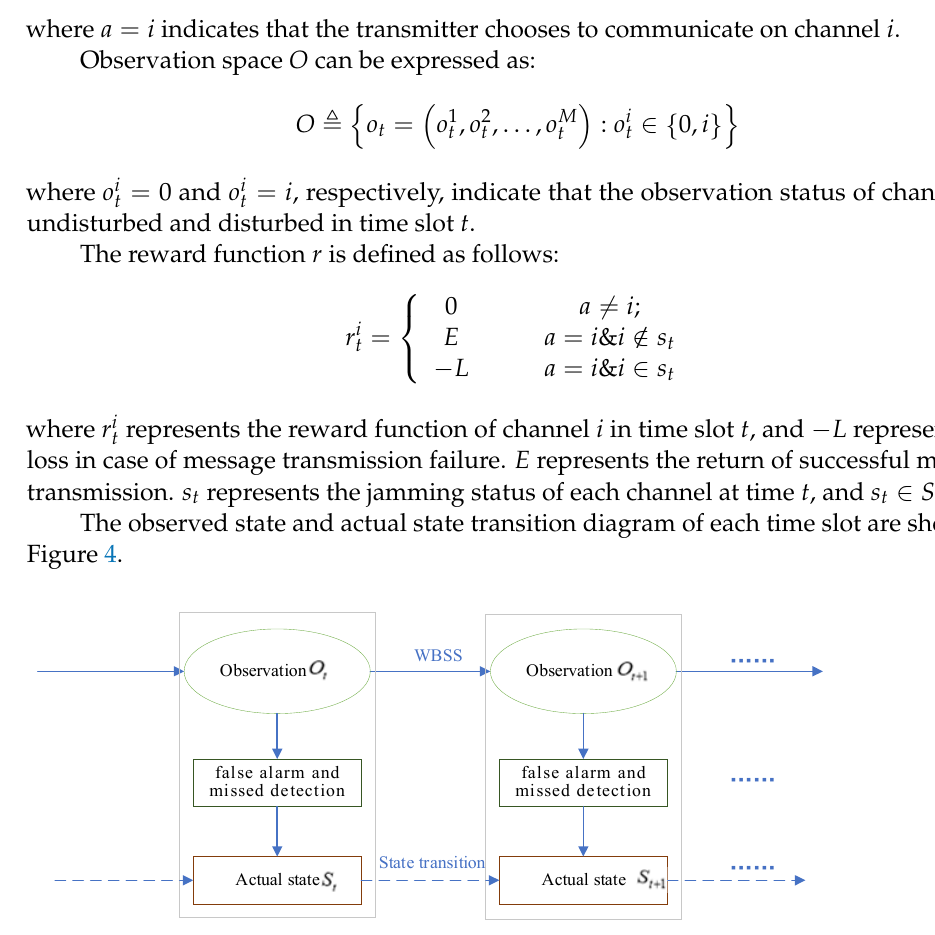
Figure 4. The observed state and actual state transition diagram of each time slot.